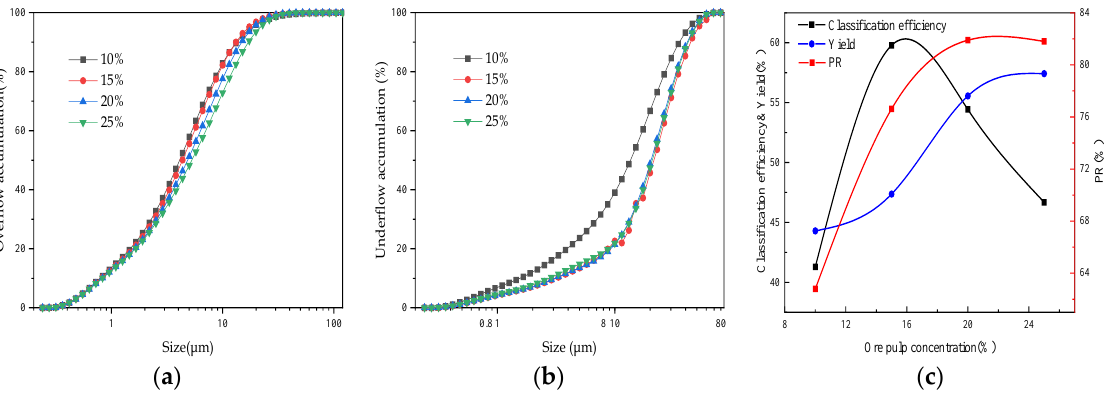
Figure 5. ( a ) Overflow particle size; ( b ) underflow particle size; ( c ) classification index. Experiment on the effect of ore pulp concentration condition.